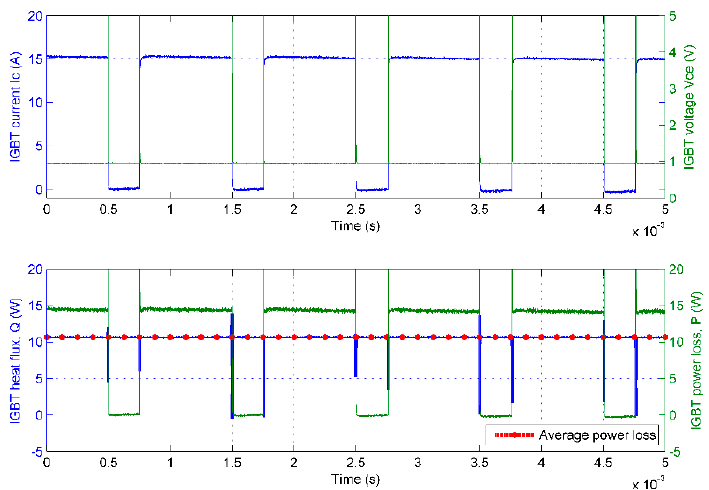
Figure 12. Collector ‐ emitter voltage V ce , collector current I c , instantaneous and average IGBT power loss P , and heat flux Q within 5 ms period.